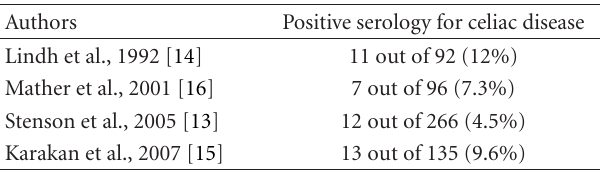
Table 2: Prevalence of positive serology for celiac disease in patients with low bone mineral